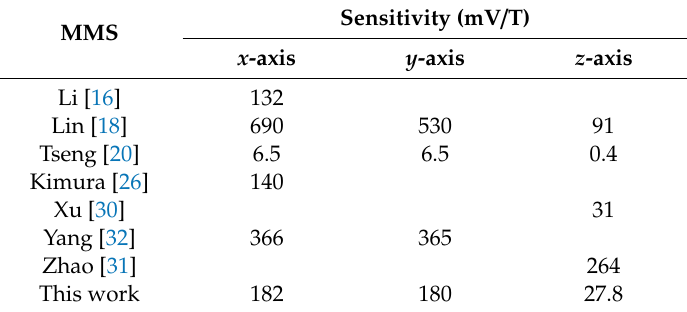
Table 1. Sensitivity for various